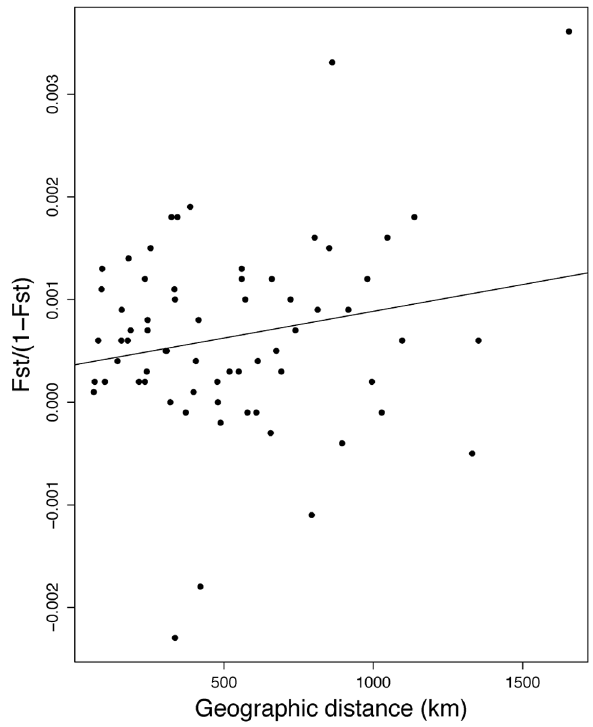
Figure 3. Isolation-by-distance analysis. The relationship between genetic distance (F ST /1-F ST ) and geographic distance is shown for all pairwise locations, excluding the Strait of Georgia and Bowie Seamount sample locations. No significant correlation was detected with a Mantel test (P . 0.25).